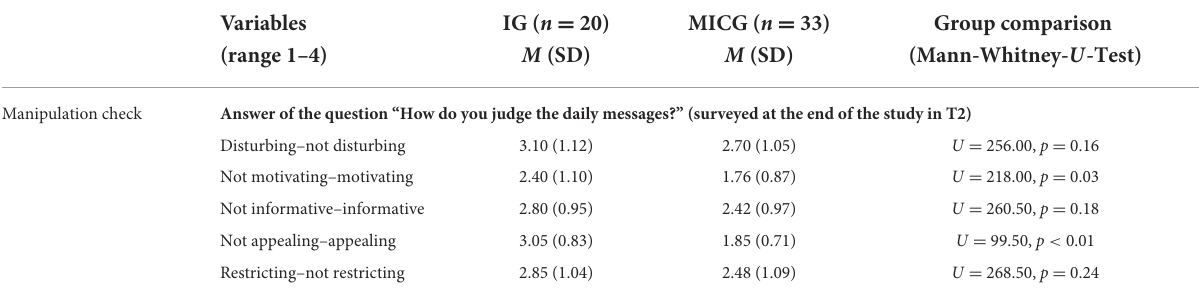
TABLE 2 Results of the manipulation check regarding the rating of the daily messages during the intervention phase for both groups (IG, intervention group; MICG, minimal intervention control group). Variables Group